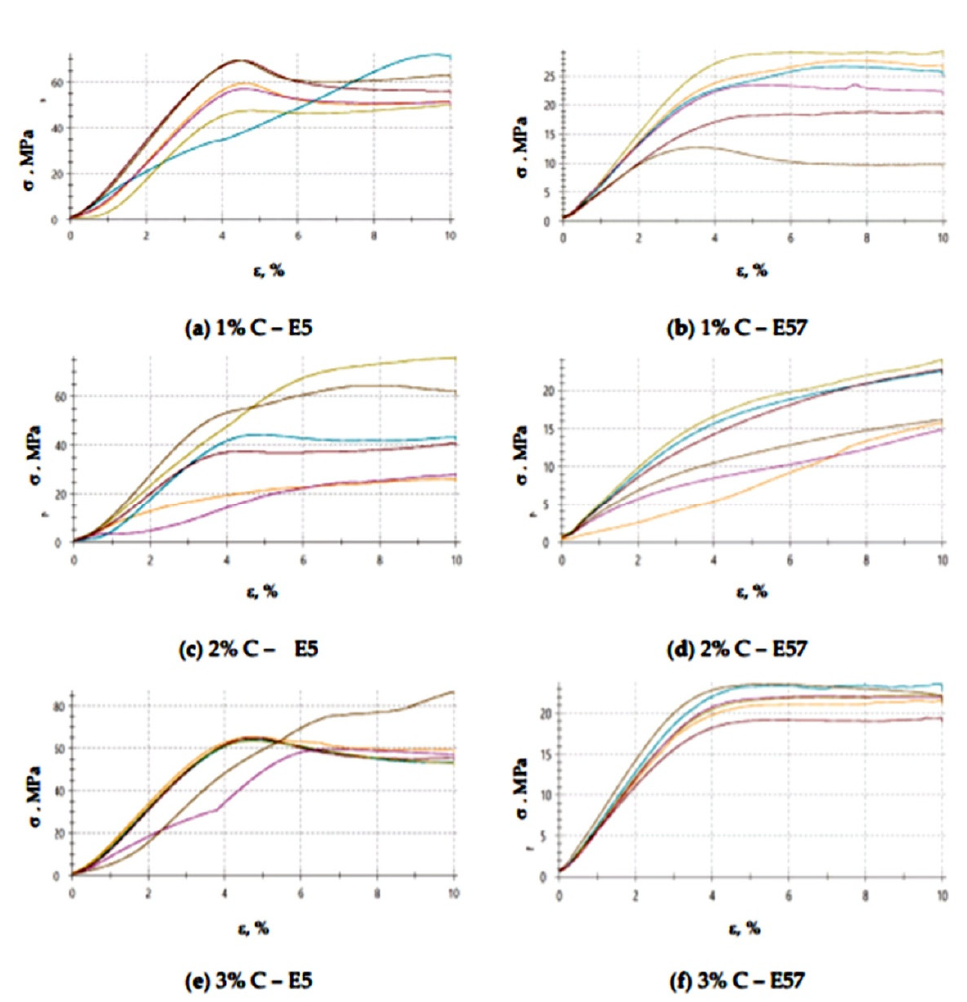
Figure 10. Stress–strain curves of the E5 / PAC / 100:80 and E57 / PAC / 100:80 epoxy specimens modified